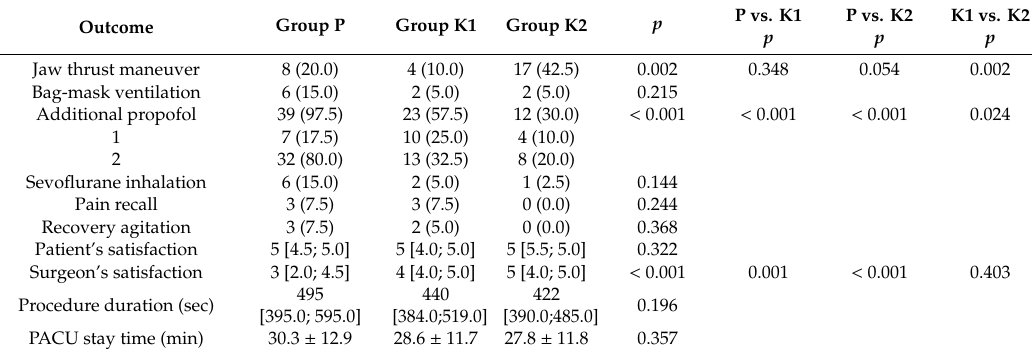
Table 3. Intraoperative and postoperative results as secondary